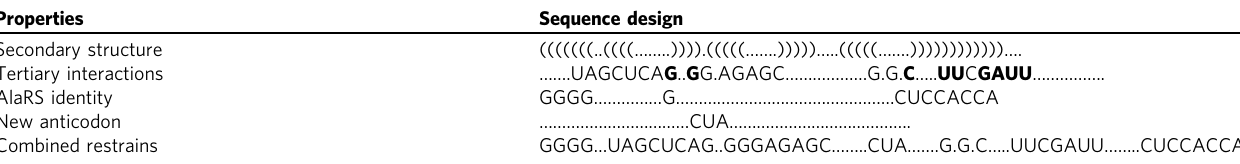
Table 1 Design scheme of E. coli nonsense tRNA suppressors.